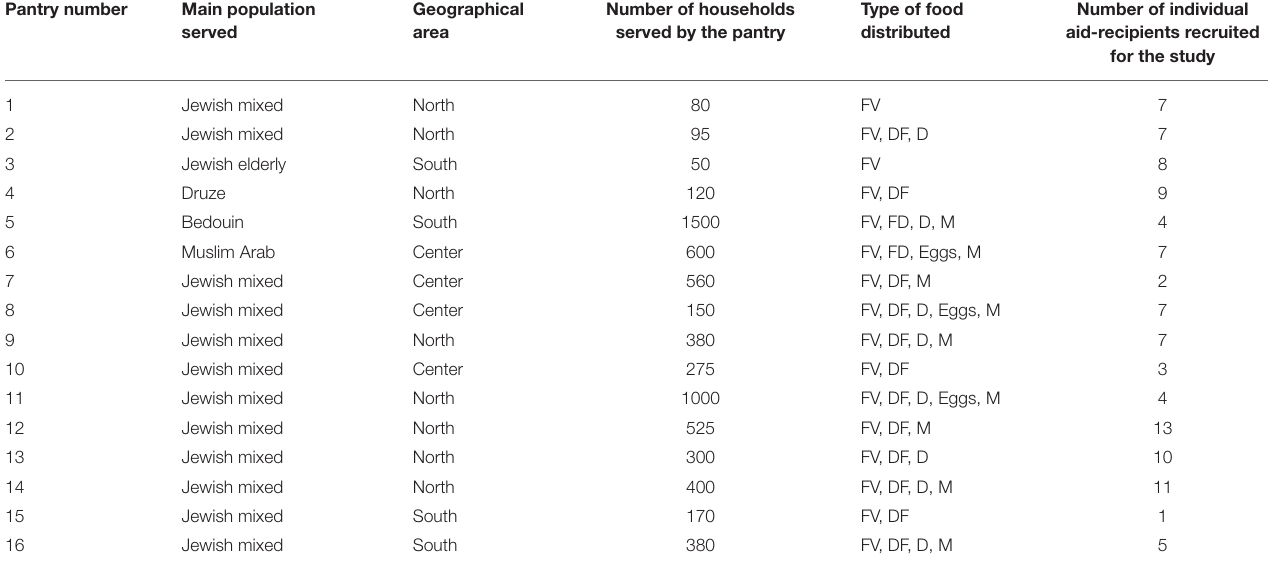
TABLE 1 | Characteristics of the food pantries participating in this study. Pantry